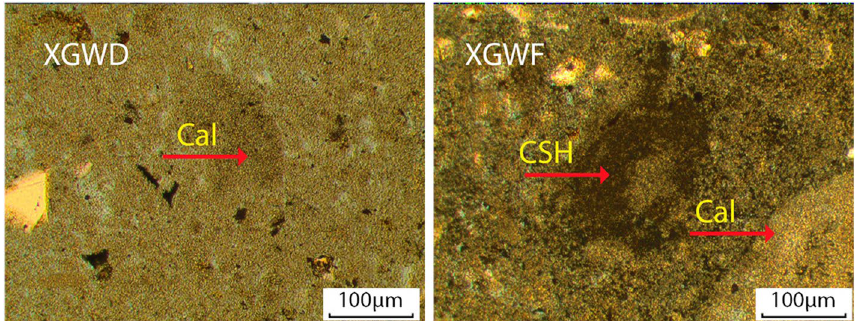
Fig. 22 Microstructure of calcium-rich lime mortar (All ppl). Left: bedding mortar consisting of a dense mortar matrix as a fine, homogeneous microstructure with predominantly smaller lime patches. Right: pointing mortar with lumps of lime covered by fine crystalline cloud-like structures, indicating the CSH phase (Source: Tanja Dettmering and Bernhard Middendorf)